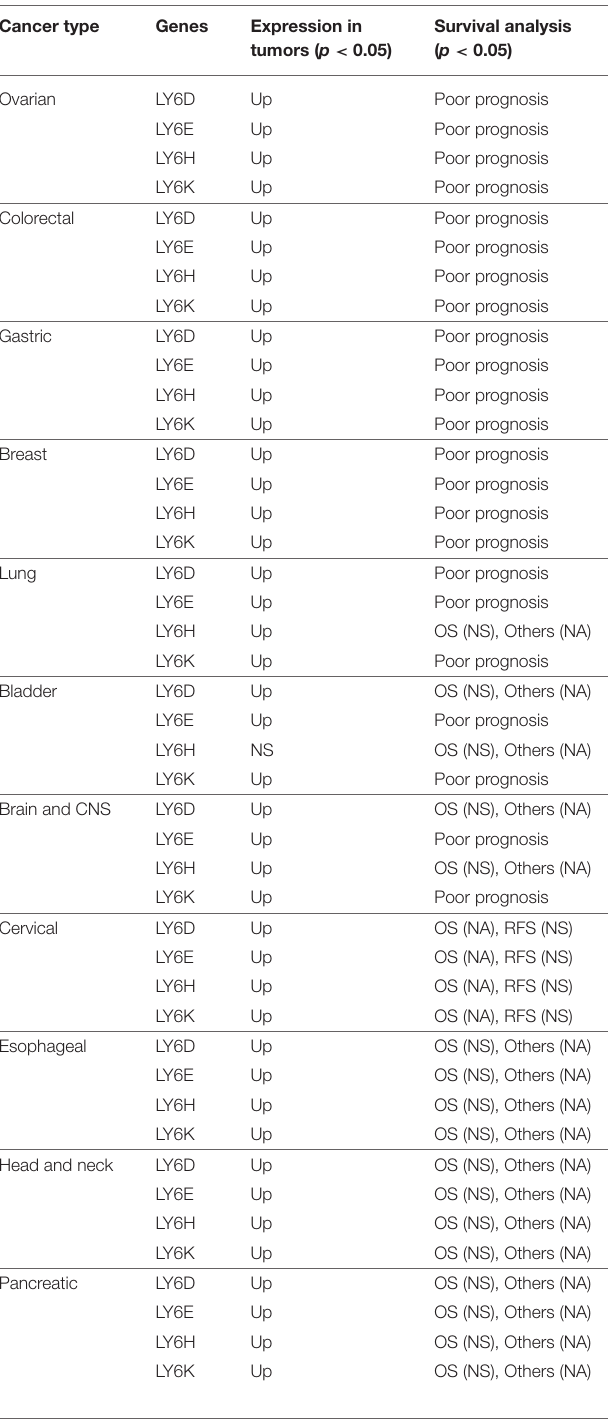
TABLE 2 | Correlation of high mRNA expression and patient survival outcome in multiple cancer